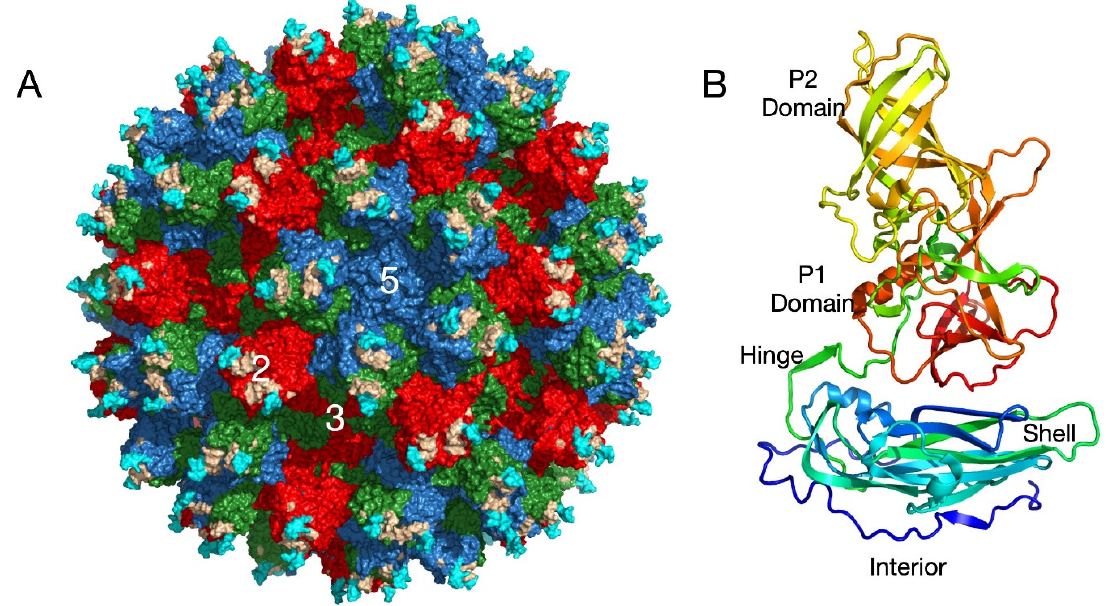
Figure 1. Overall architecture of the caliciviruses. ( A ) This figure shows the entire capsid of murine norovirus (MNV) observed in the cryo-EM structures in the presence of bile [11] and at low pH [20]. The subunits A, B, and C are shown in blue, green, and red, respectively. The P domain dimers are composed of A and B subunits around the 5-fold axes and of C dimers at the 2-fold axes. Also highlighted are the A’-B’ (cyan) and E’-F’ (tan) loops discussed in the text. ( B ) Shown here is one copy of the capsid protein colored from blue to red as the chain extends from the amino to carboxyl termini. Note that this represents the contracted form of the capsid seen at low pH [20] or in the presence of bile [11].